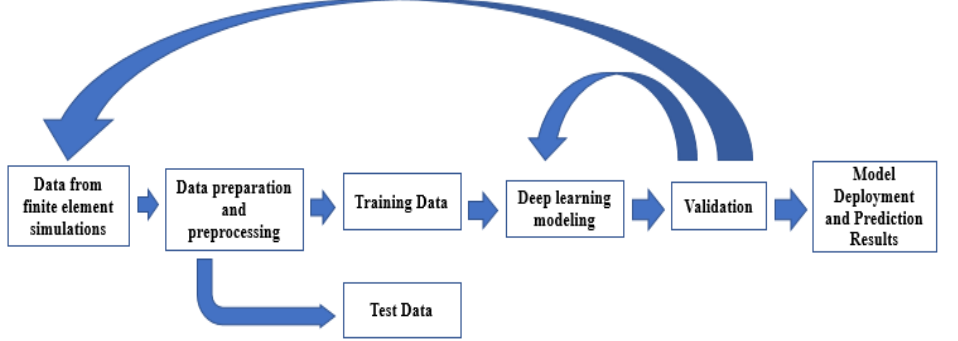
Figure 4. ( a ) Finite Element Modeling (FEM) 3D model; ( b ) Simulated thermogram at t = 106.5 s; ( c ) Real experimental data t = 106.5 s.